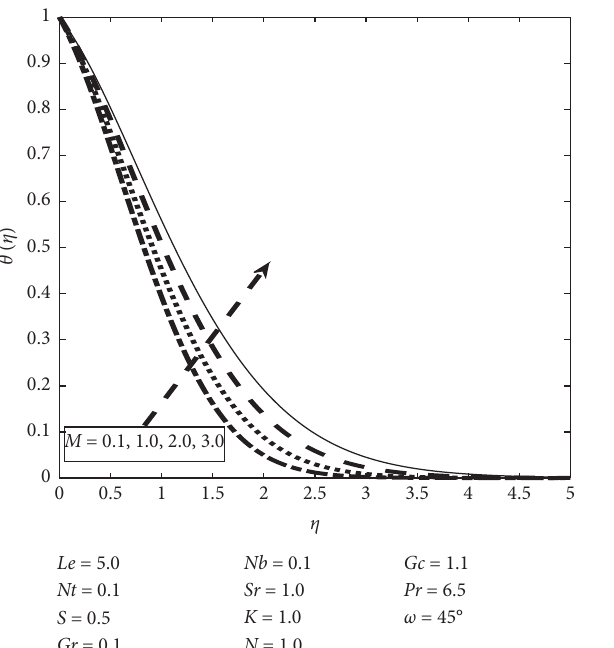
Figure 9: Temperature profile for several values of M